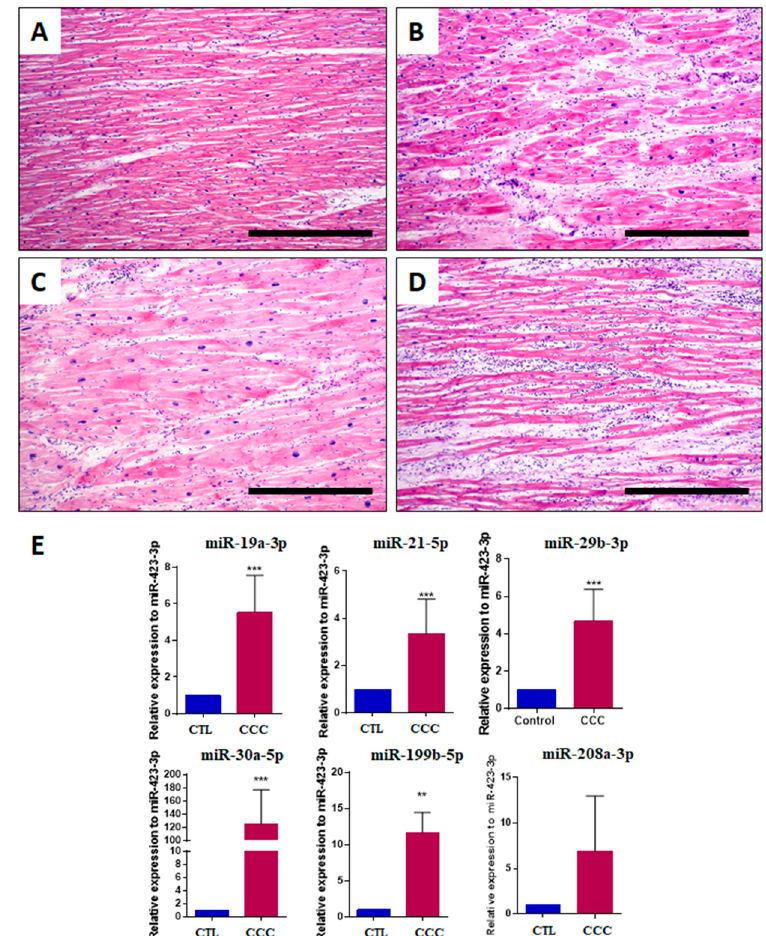
Figure 3. Histological and miRNA analysis in explanted hearts from chronic Chagas disease subjects. Left ventricle sections stained with H&E showing ( A ) a normal area of myocardium with minimal myocyte hypertrophy; ( B ) interstitial fibrosis and moderate myocyte hypertrophy; ( C ) severe myocyte hypertrophy, with the presence of enlarged and pleomorphic nuclei, varying in shape and size. The fibers are random and there is focal interstitial inflammation (top left corner); ( D ) multifocal inflammation characterized by accumulation of plasma cells and mature lymphocytes. The nuclei of myocytes are mildly enlarged and pleomorphic (moderate myocyte hypertrophy), and there is mild interstitial fibrosis. Bars = 500 µ m; ( E ) miR-19a-3p, miR-21-5p, miR-29b-3p, miR-30a-5p, miR-199b-5p and miR-208a-3p evaluation by RT-qPCR, using 2 − ∆∆ Ct method and normalized with miR-423-3p. Data represent the mean ± SEM. Controls (CTL), n = 8, and chronic Chagas cardiomyopathy (CCC), n = 9, analyzed using Student’s t -test, *** p < 0.001, ** p < 0.01.